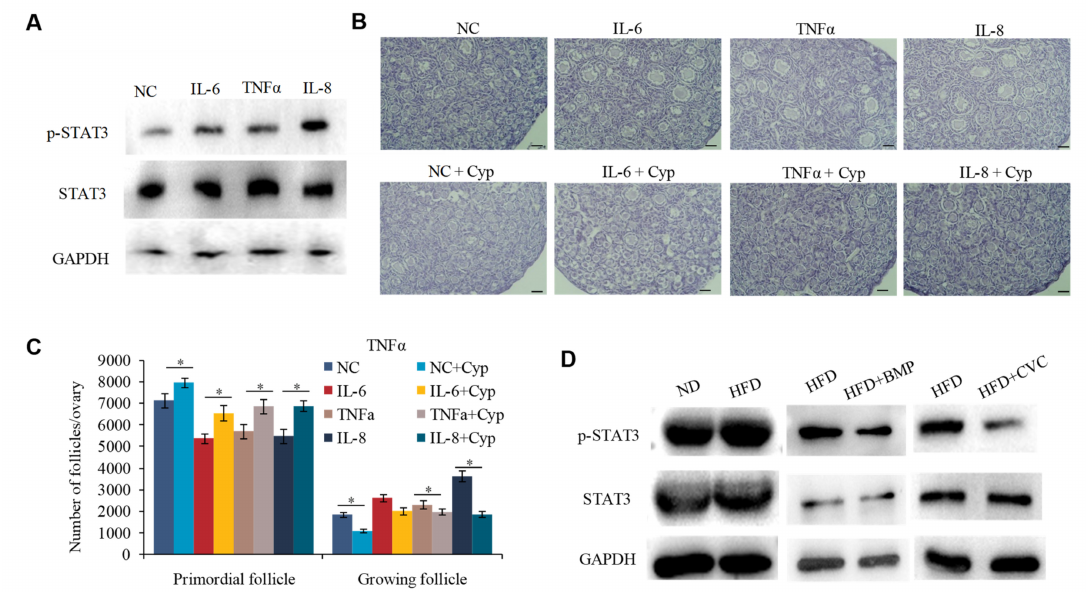
Figure 5. IL-6, IL-8, and TNF α promote the overactivation of primordial follicles in HFD mice by activating STAT3 expression. ( A ) WB analysis of the protein levels of p-STAT3, STAT3, and GAPDH in the ovary supplemented with IL-8 or IL-6 or TNF α . ( B , C ) Representative H&E staining images ( B ) and follicle number counts ( C ) in the IL-8, IL-6, or TNF α - treated ovaries supplemented with STAT3 inhibitor Cyp ( n = 10). Scale bar = 50 µ m. * p < 0.05. ( D ) WB analysis of the protein levels of p-STAT3, STAT3, and GAPDH in the ovaries of the ND, HFD, HFD+BMP, and HFD+CVC